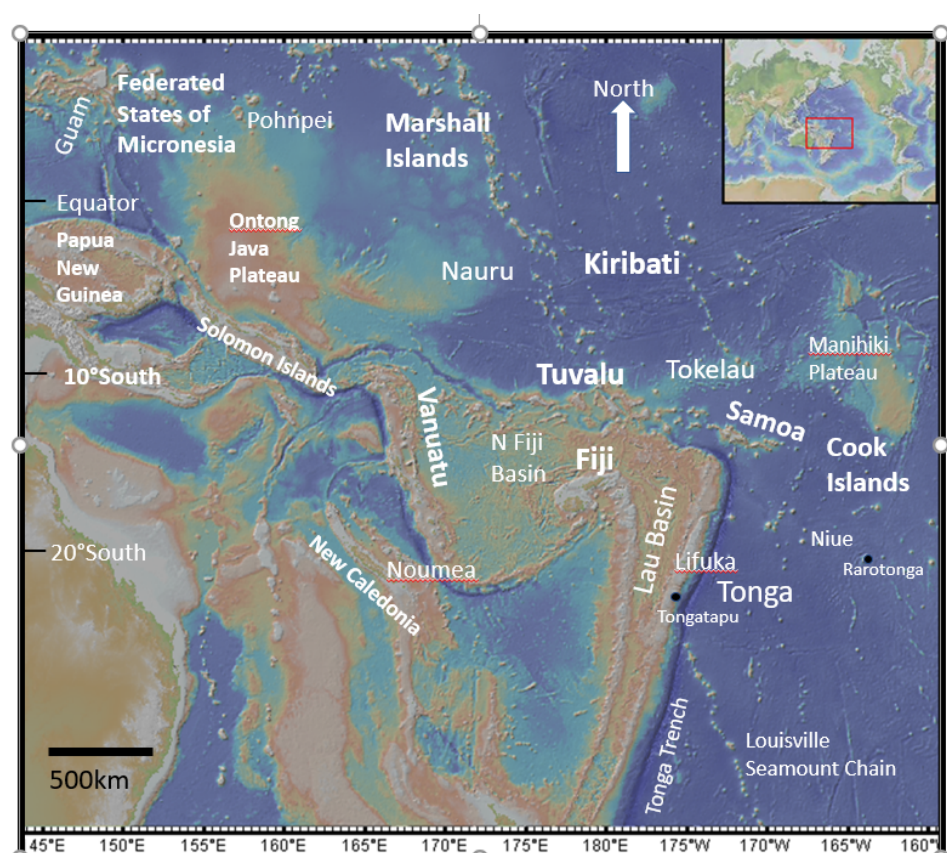
Figure 4. Geodynamic and geographical setting of the Pacific Islands region. This Africa-sized region is located in the western part of the Pacific Ocean, either side of the equator. Inset shows the position of the region on a map of the Earth. The region is a dynamic geological area with a highly diverse set of oceanic tectonic features. Island arc nations such as Fiji, Solomon Islands, Vanuatu, Tonga, and the Papua New Guinea (PNG) islands are situated close to ocean trenches that mark subduction processes. These islands are higher volcanic islands. Atoll countries such as Cook Islands, Tuvalu, Kiribati, Federated States of Micronesia, Tokelau, and Marshall Islands form on extinct volcanic seamounts and can vary in elevation from just above sea level to raised elevations. Samoa, Louisville, and the Ontong Java and Manihiki Plateau are the products of deep-seated mantle plumes with the extensive plateaus forming important components of maritime boundary submissions. New Caledonia and parts of PNG are formed from older continental material. Colors in the diagram represent topographic elevations with the deepest blues being the deepest ocean, (mainly 4–6 km beneath sea level, with trenches extending to c. 10 km beneath sea level), paler colors representing shallower parts of the ocean (ocean plateau and drowned continental shelves), and land masses such as Australia in pale green colors. Acknowledgements to Google Earth for the base